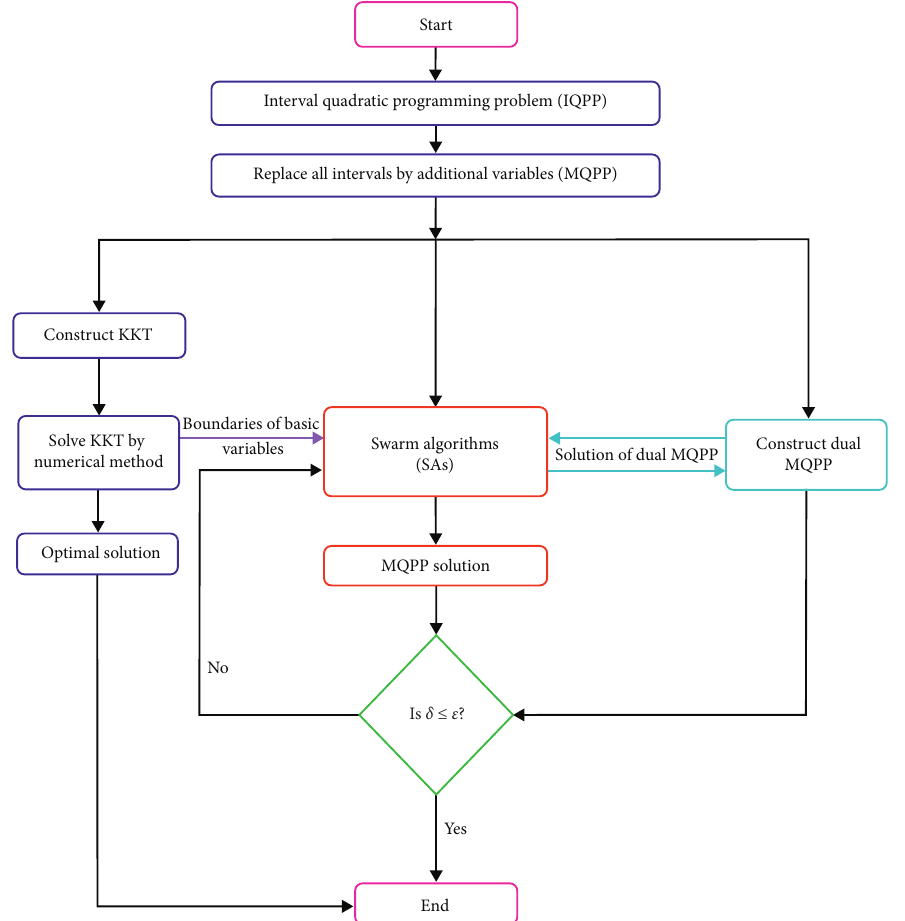
Figure 1: The flowchart of the proposed approach.